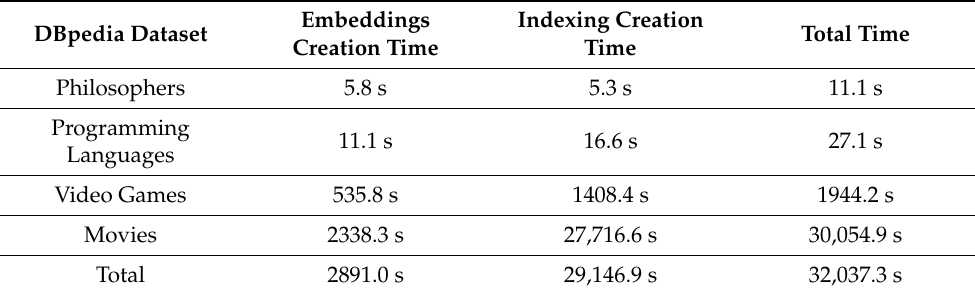
Table 3. Execution Time (in seconds) for creating the embeddings and the